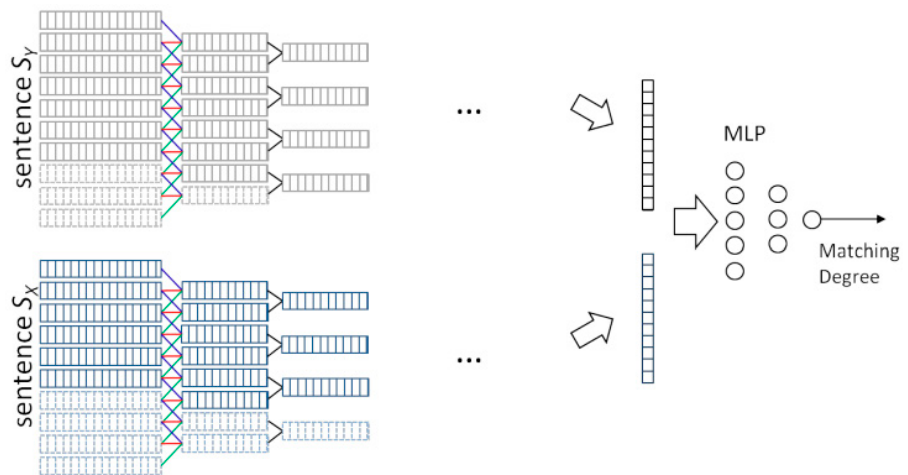
Figure 5. Architecture-I for matching two sentences [50].